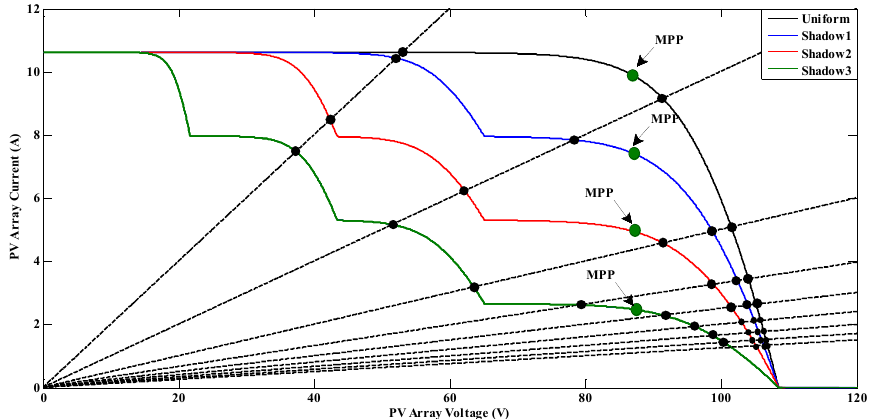
Figure 5. The operating points for different irradiations under partially shaded conditions.